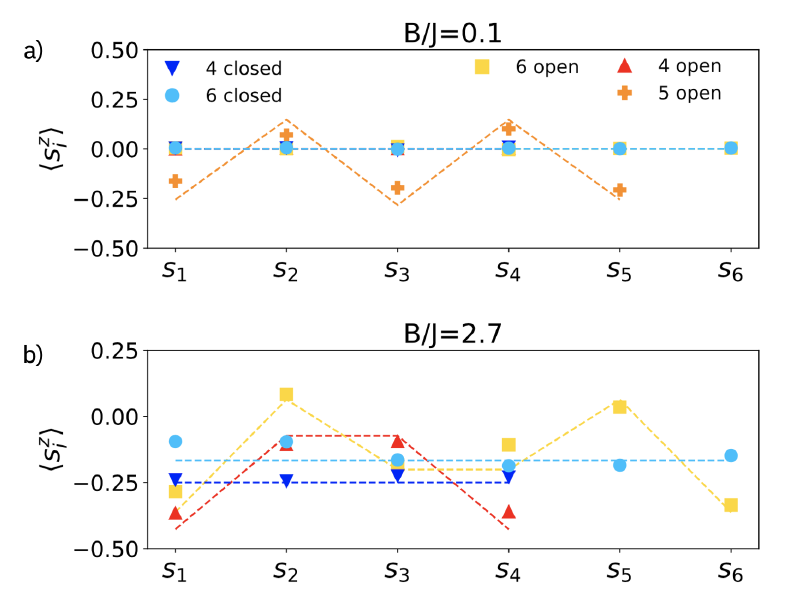
(cid:105) computed on i